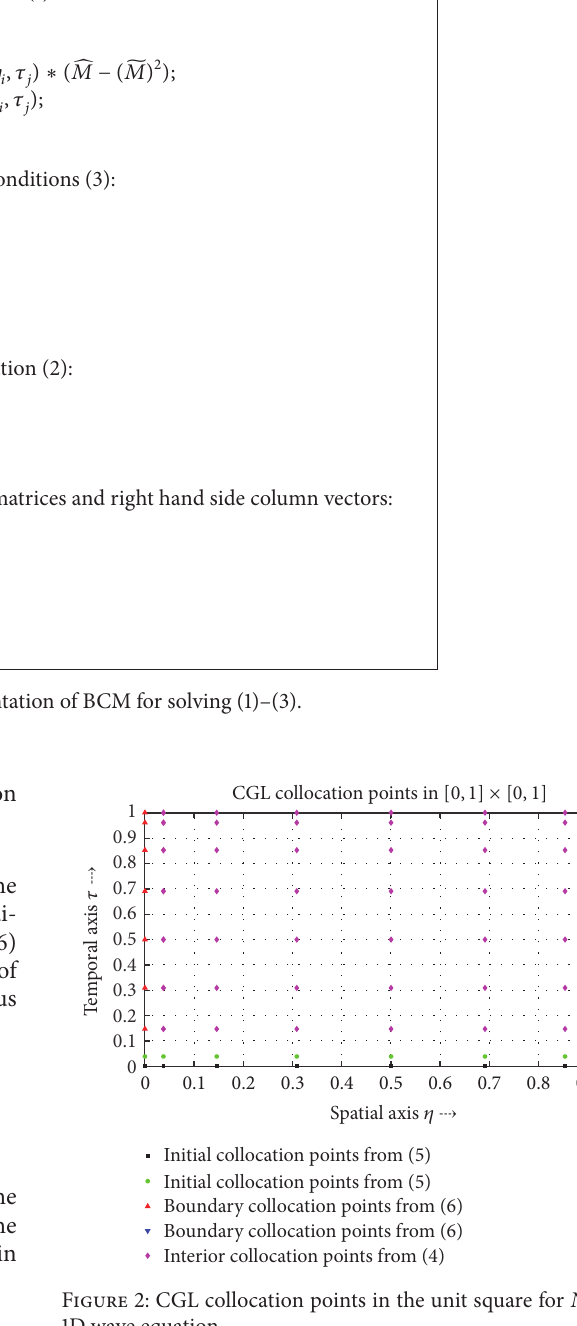
Figure 2: CGL collocation points in the unit square for 𝑁 = 8 for 1D wave